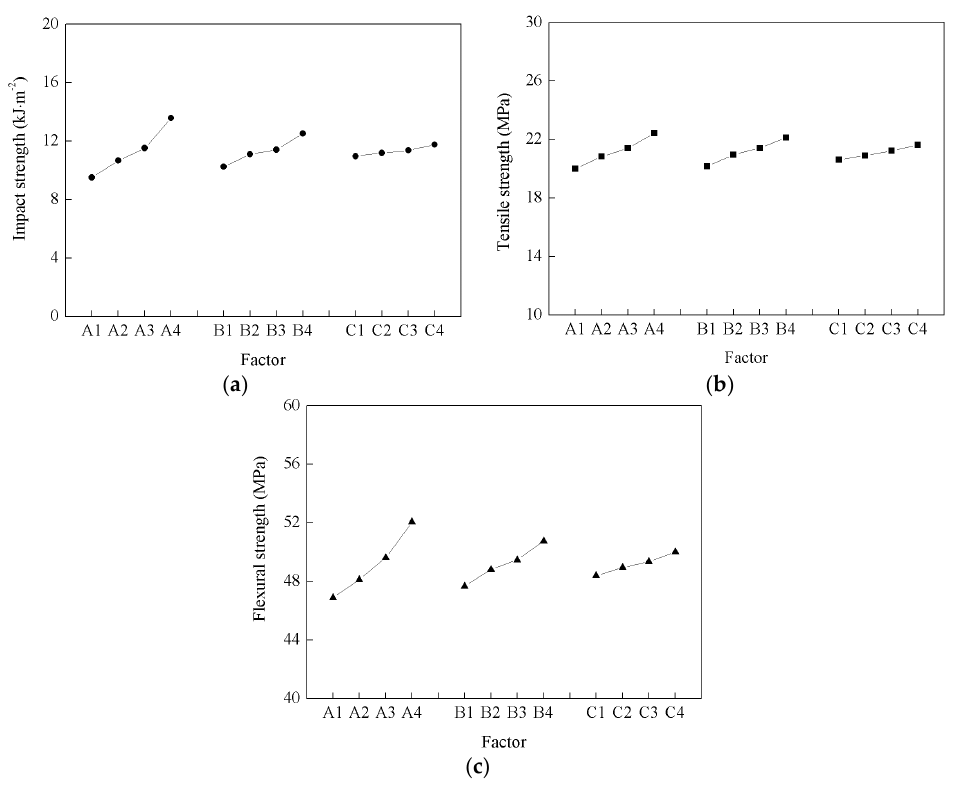
Figure 1. Range analysis of the effect of the process parameters on the impact, tensile, and flexural strengths of the wood fiber/high-density polyethylene (HDPE) composites. ( a ) Range analysis of wood plastic composite (WPC) impact; ( b ) Range analysis of WPC tensile; ( c ) Range analysis of WPC flexural.